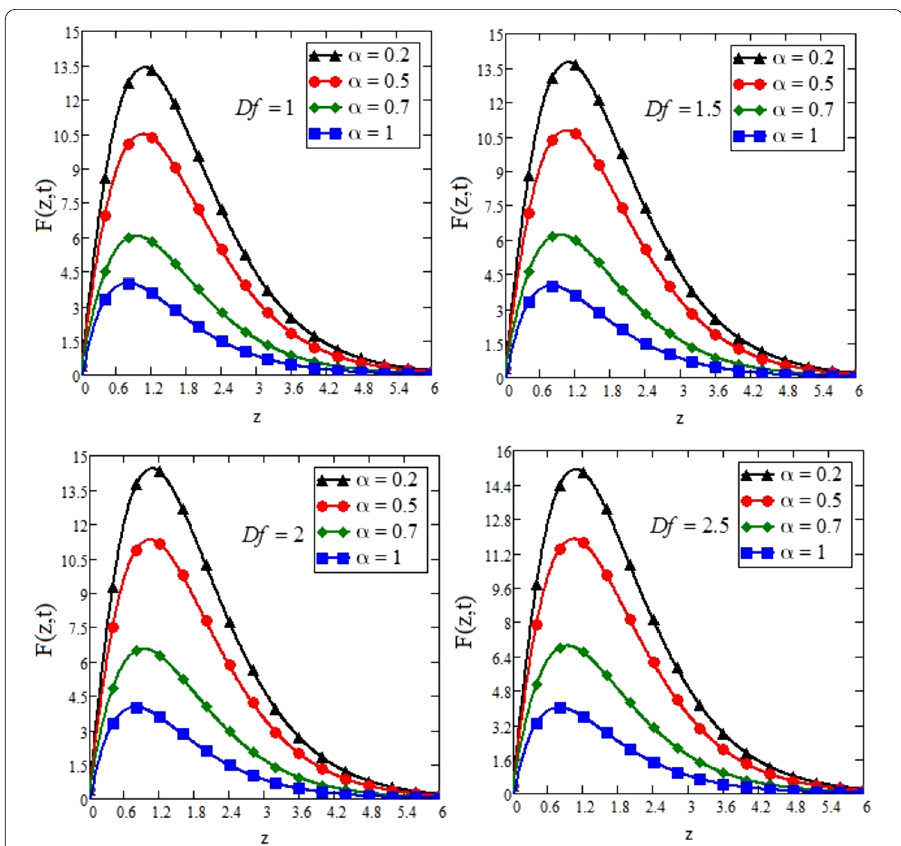
Figure 11 Impact of Df on the velocity distribution of Jeffrey nanofluid